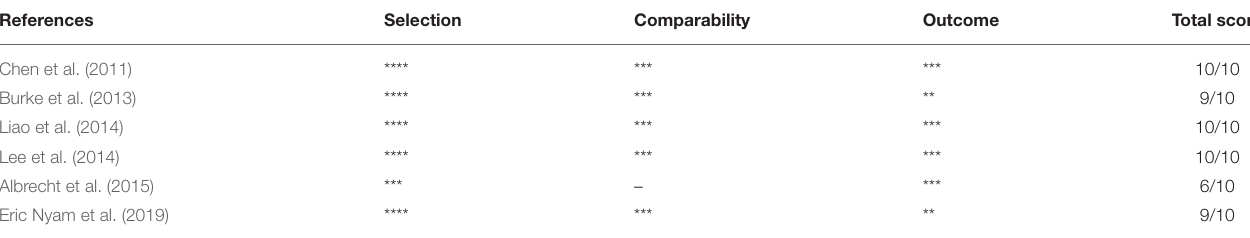
TABLE 2 | Risk of bias assessment for cohort studies (based on modified Newcastle-Ottawa scale) on stroke in patients with